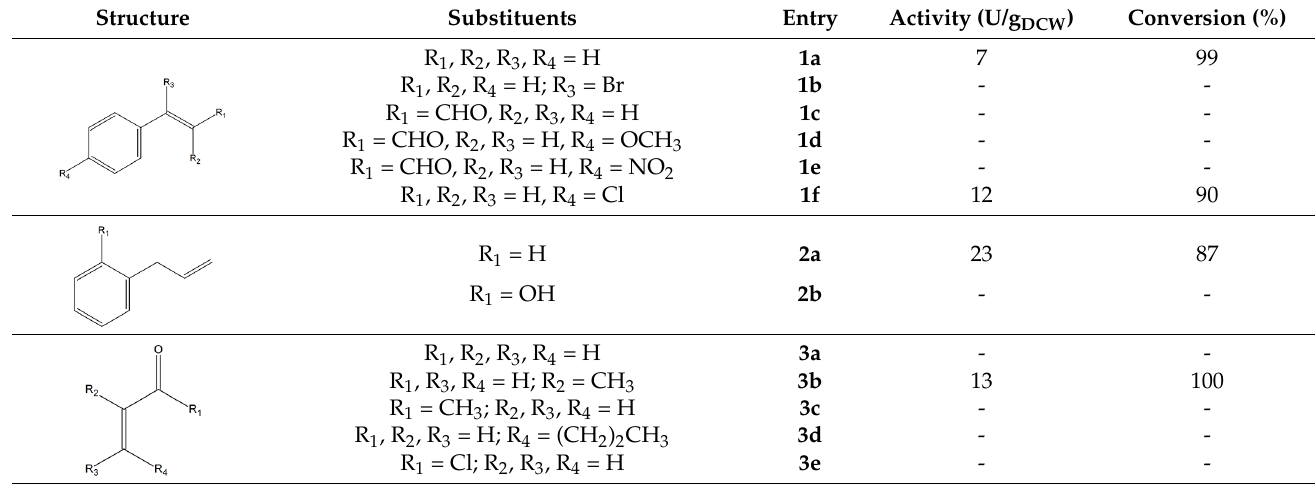
Table 2. Substrate specificity of recombinant CE of SMO.